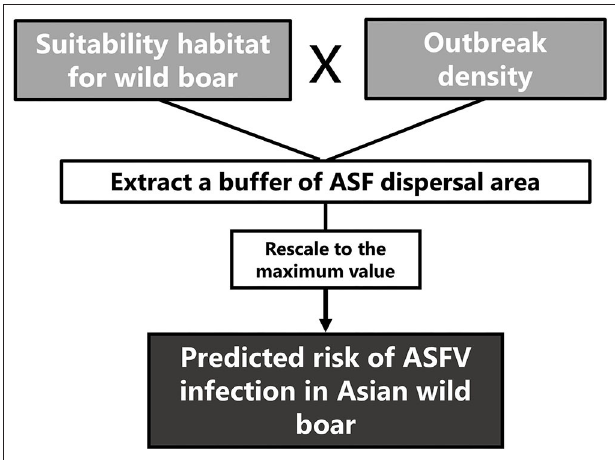
FIGURE 1 | Scheme of the procedure for predicting the risk of African swine fever virus (ASFV) in wild boar in Asia.